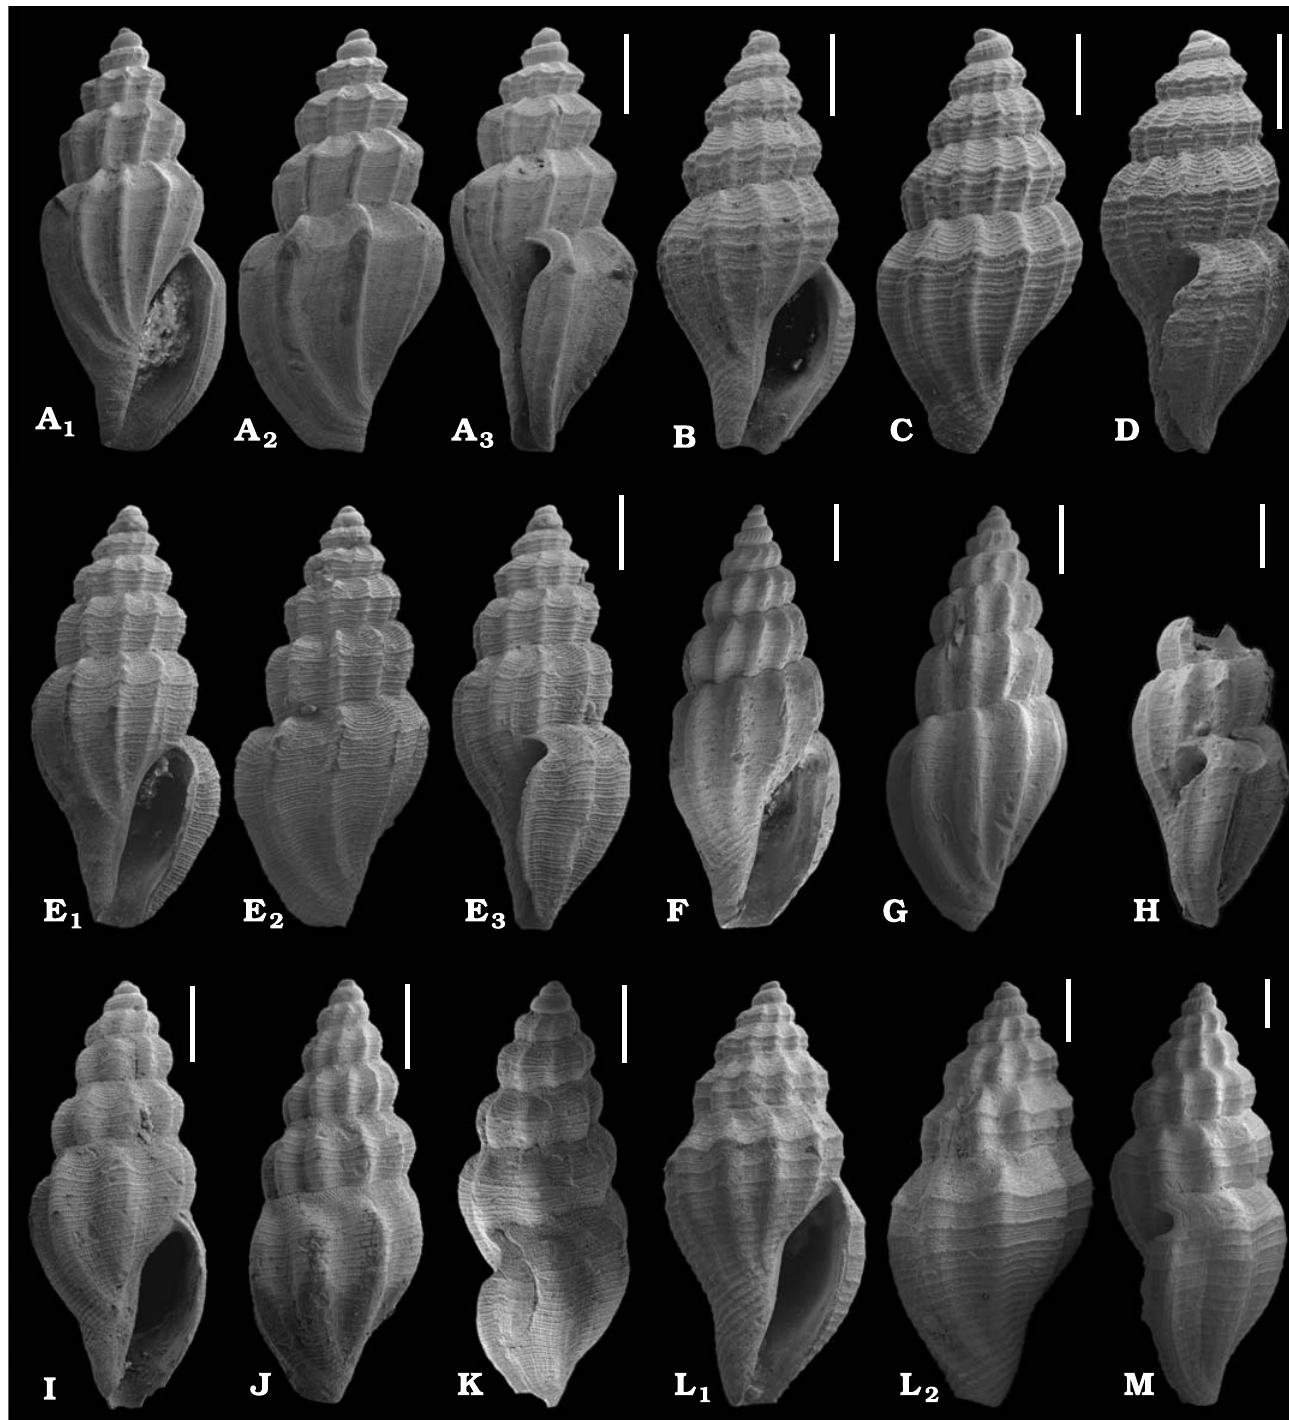
Fig. 5. SEM images of shell features of new conoidean gastropods from early Serravallian of western Ukraine, Varovtsi (A–E, I–M), Horodok (G), and Velyka Levada (F, H). A . Mangelia angulicosta sp. nov., MGGC-24506/6. B – D . Mangelia larga sp. nov. B . MGGC-24508/11. C . MGGC-24508/1. D . MGGC-24508/12. E . Mangelia pseudorugulosa sp. nov., MGGC-24510/9. F – H . Mangelia odovychenae sp. nov. F . MGGC-24512/1. G . MGGC- 24512/10. H . MGGC-24512/topotype. I – K . Bela varovtsiana sp. nov. I . MGGC-24517/8. J . MGGC-24517/5. K . MGGC-24517/6. L , M . Bela ? robusta sp. nov. L . MGGC-24519/8. M . MGGC-24519/1. Views: A 1 –L 1 , B, F, I, apertural; A 2 − L 2 , C, G, J, dorsal; A 3, D, E 3, H, K, M, lateral. Scale bars 1 a sinusigera. Teleoconch of 4.4 whorls (sd 0.3 wh), evenly spaced, rounded ribs (usually 9 on second whorl), extending m rounded in profile, with axial and subdued spiral sculpture; across the sutures on spiral whorls until the base on the suture slightly undulating. Axial sculpture of opisthocline, last whorl; growth lines evident. Spiral sculpture of dense,